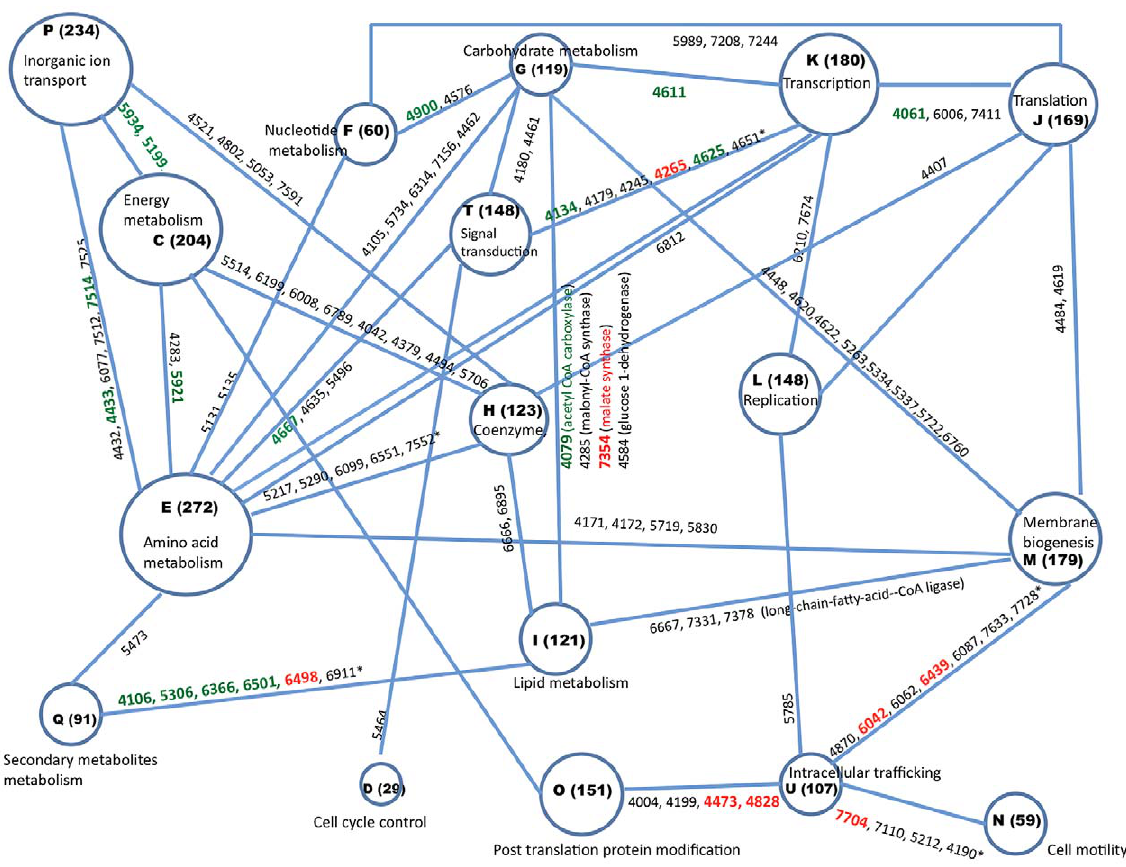
Figure 3. Metabolic network showing the number of O.carboxidovorans proteins identified in each COG category in the current study. Proteins (referred by locus tag number OCAR_xxxx) listed on lines connecting COG categories are classified in both COG categories. Proteins that showed significantly increased expression in syngas and acetate medium compared to TSB medium are colored red, and proteins that had significantly decreased expression in syngas and actetate medium are green. The size of the circles represents the number of proteins in that COG. Protein names and COG groups along with their GI and other details can be accessed from NCBI (http://www.ncbi.nlm.nih.gov/ genome?Db=genome&Cmd=Retrieve&dopt=Protein + Table&list_uids=23052). The COG categories indicated are the same as in Figure 2. *Indicates additional proteins classified in both COG categories not shown in the figure.